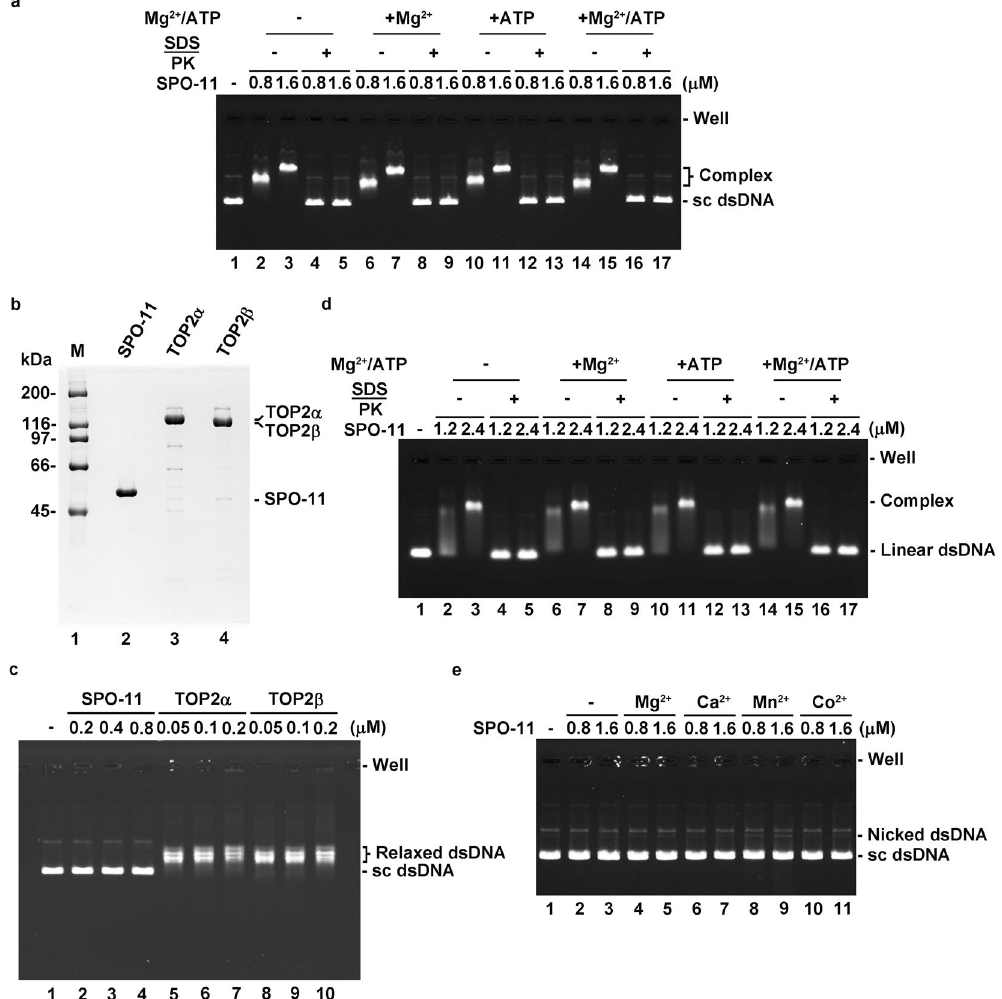
Figure 6. Lack of DNA cleavage activity in C. elegans SPO-11. ( a ) The indicated concentration of SPO-11 was incubated with negatively supercoiled dsDNA (sc dsDNA) with or without Mg 2 + , ATP, or Mg 2 + -ATP as indicated. DNA was released from nucleoprotein complexes by treatment with SDS and proteinase K (PK). ( b ) Purified SPO-11, human TOP2 α , and TOP2 β were analyzed by SDS-PAGE. ( c ) The indicated concentration of SPO-11, TOP2 α , or TOP2 β was incubated with negatively supercoiled dsDNA in the condition with the presence of Mg 2 + -ATP. ( d ) Linear dsDNA was used as the substrate to examine the DNA cleavage activity of SPO-11. ( e ) SPO-11 was examined for DNA cleavage activity with the indicated metal